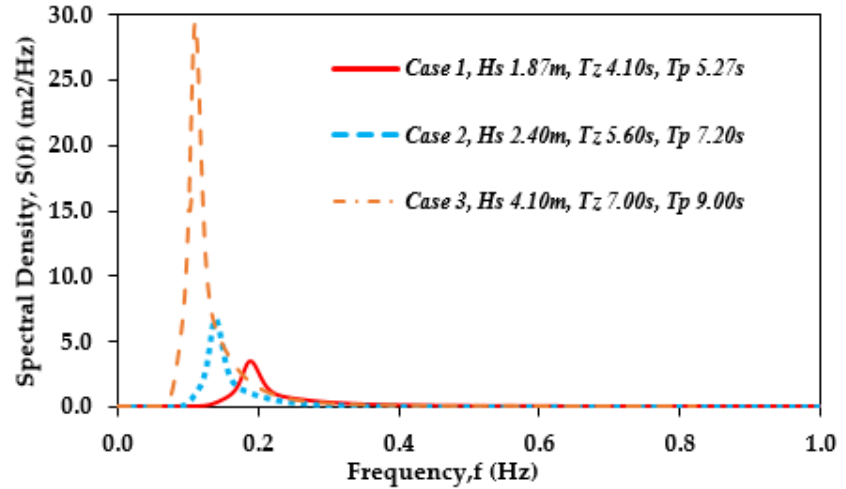
Figure 14. JONSWAP Spectrum for the 3 Sea States or Environmental Cases. Table 7. Wave Parameters for the 3 load Cases.